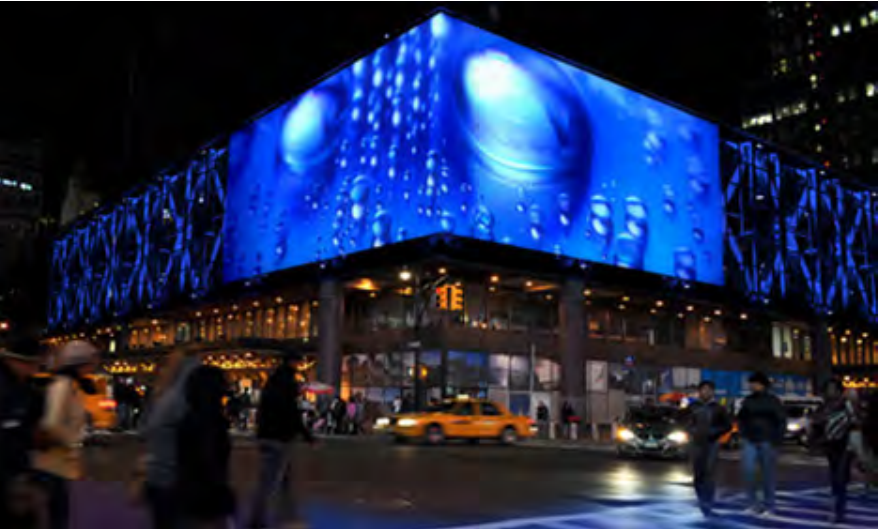
Figure 6. New York City’s PortAuthority Bus Terminal